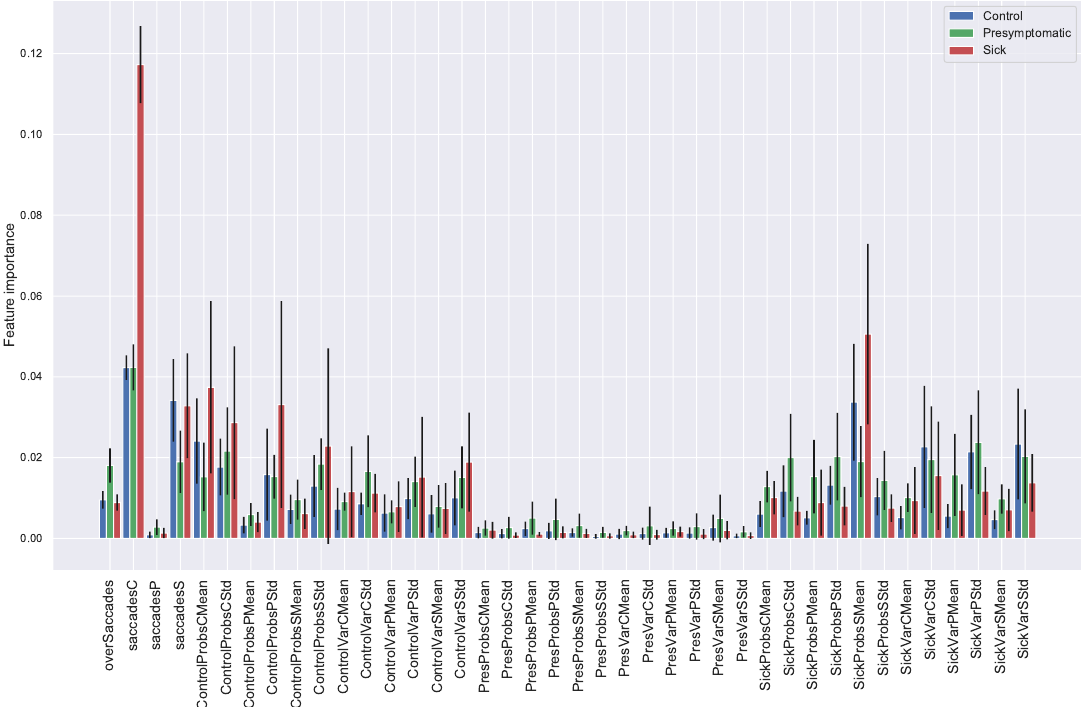
Figure 8. Importance of the features for each class in